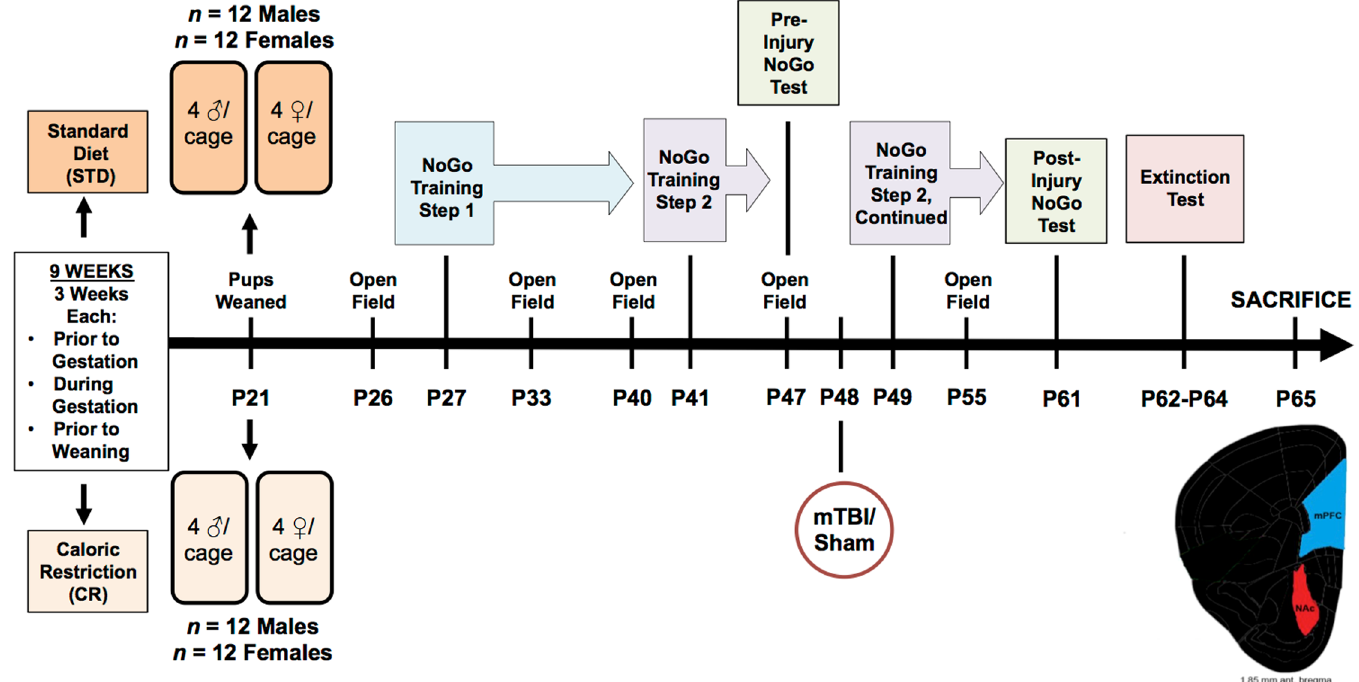
Fig 1. Illustrative representation of the experimental paradigm, which includes the age that each rat underwent behavioural testing, mTBI, and sacrifice.